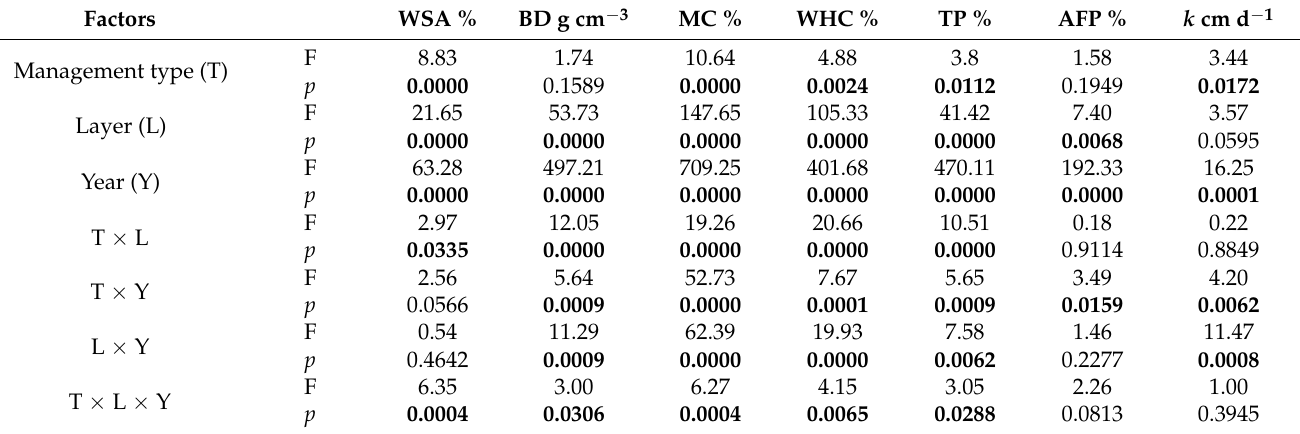
Table 2. Effects of management type (G, NT, MT and CT), sampling layer (5–10 cm vs. 25–30 cm) and year (2016 and 2018) on soil physical properties as analysed with linear mixed-effects models ( n = 96, except for aggregate stability where n = 48 per each management type and year), where the F-statistics and p -values (values ≤ 0.05 are in bold) for the factors and their interactions are reported. WSA % BD g cm − 3